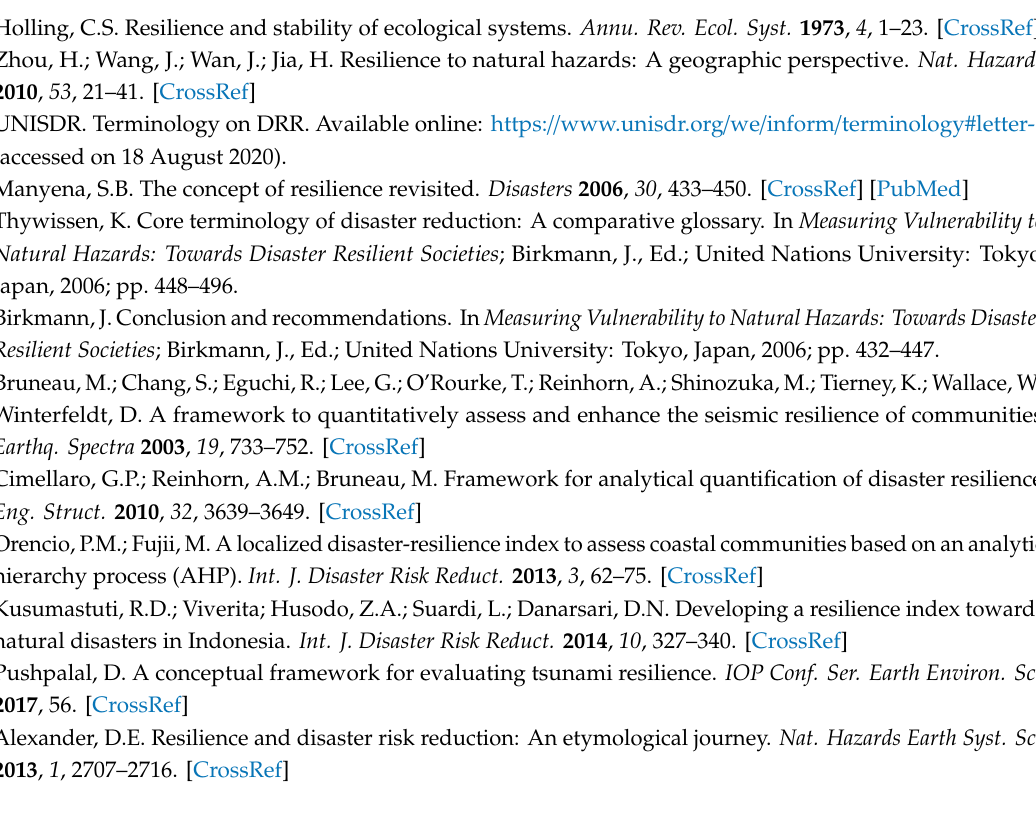
Figure S1: Maps of (a) Galle Fort GN division and (b) Manmunai North DS division, Table S1: A description of Table S2: A description of indicators / sub-indicators and methodology of enumeration (recovery potentiality), Table S3: Summary of the results (onsite capacity), Table S4: Summary of the results (instantaneous survivability), Table S5: Summary of the results (recovery